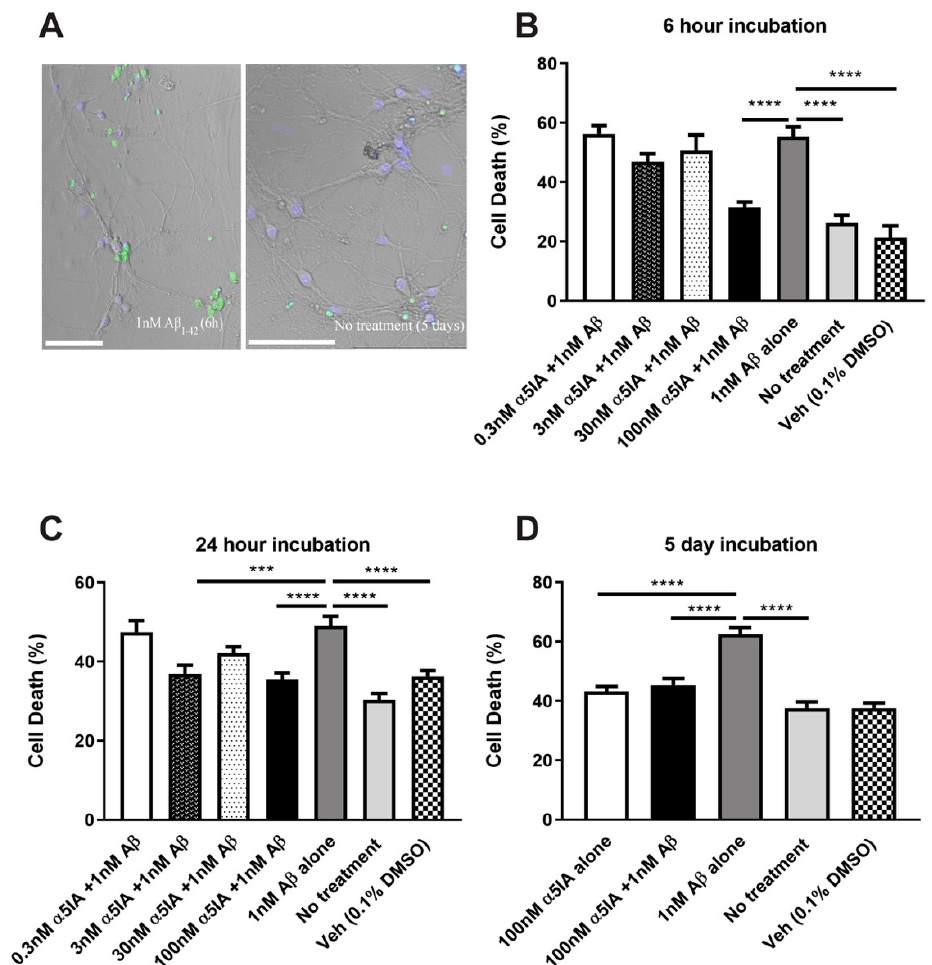
Figure 1. Cell death in mouse primary hippocampal cultures following treatment with 1 nM A β 1–42 and 0.3 nM, 3 nM, 30 nM, and 100 nM of α 5IA. ( A ) At 14 DIV, mouse primary hippocampal cells were